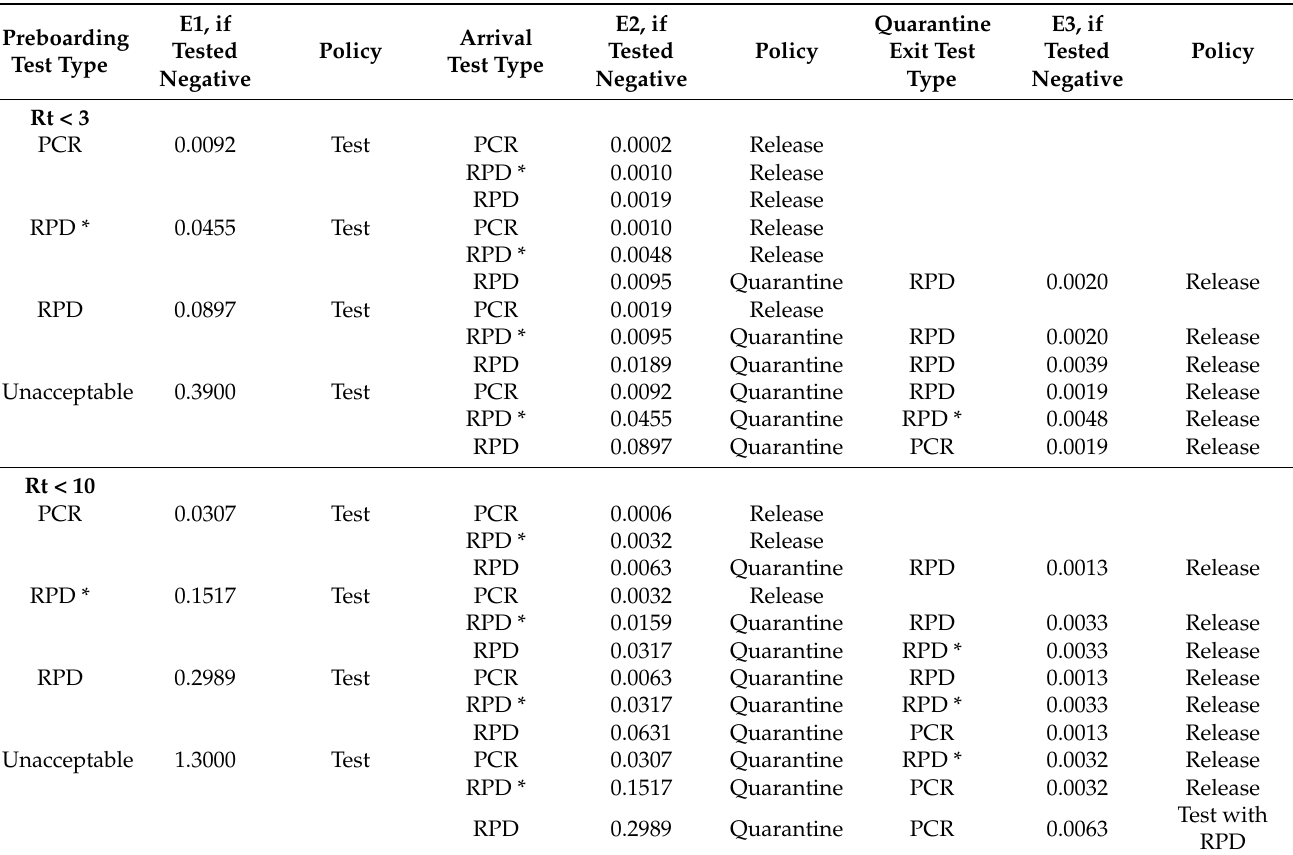
Table 1. Testing and quarantine strategies for fully vaccinated travelers (general).